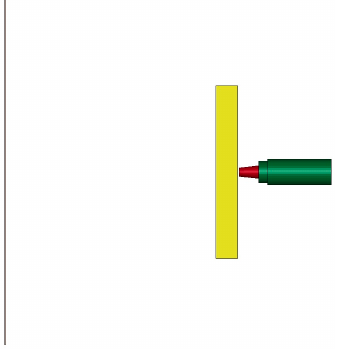
Figure 5. Numerical simulation model.